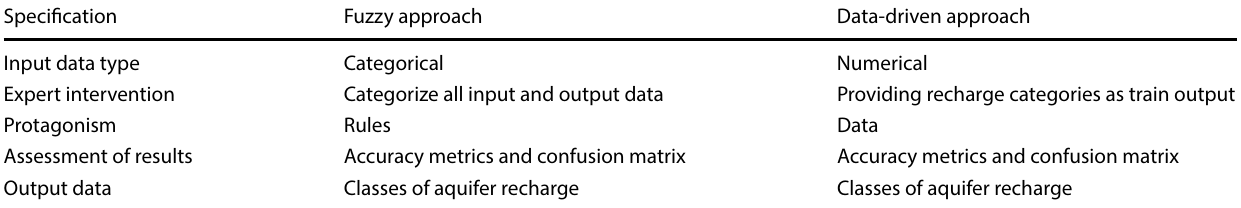
Table 1 Specification of each